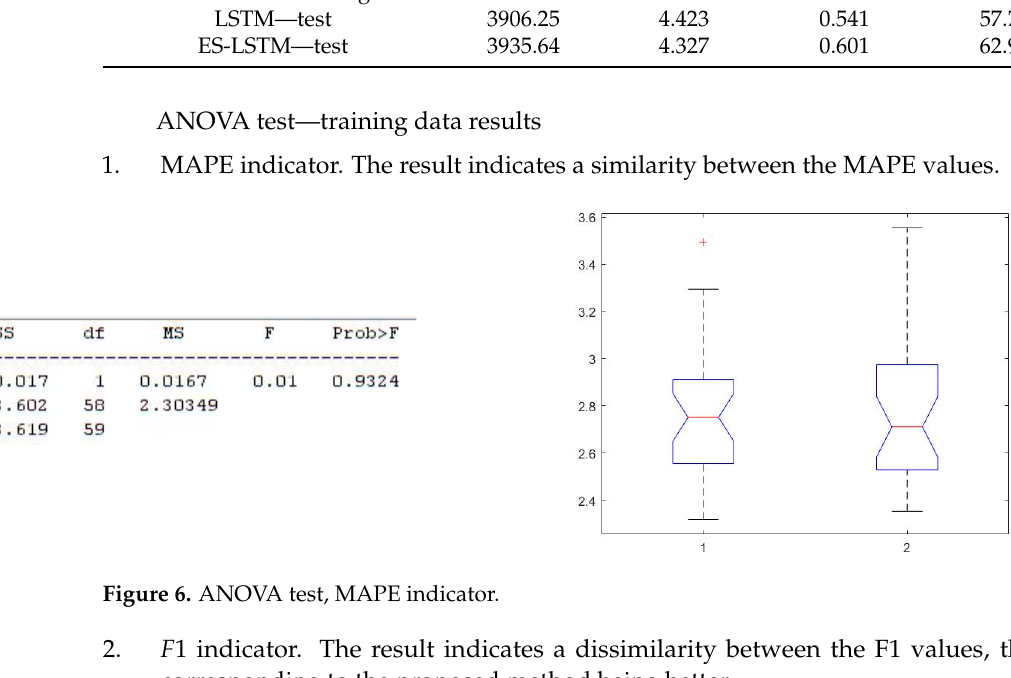
Table 1. BTC–USD: accuracy comparison.